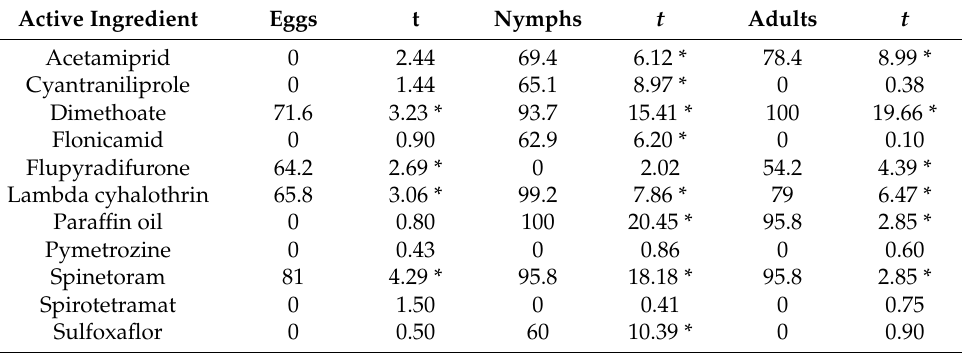
Table 2. Percentage of corrected mortality (%) in Trioza erytreae eggs, nymphs and adults in contact bioassays. The mortality was recorded 96 h after treatment for eggs, and 24 h after treatment for nymphs and